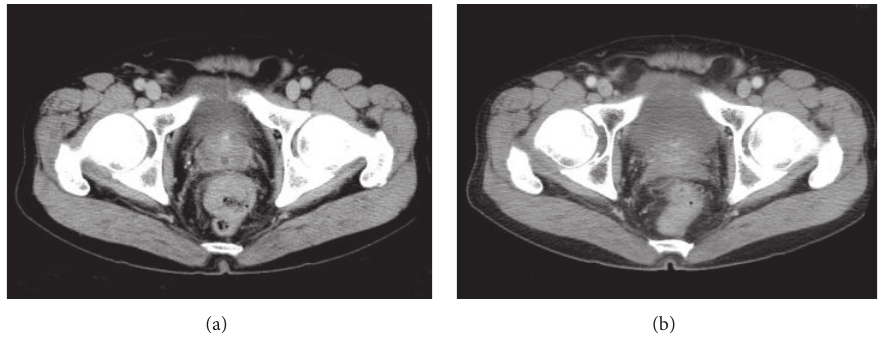
Figure 2: Abdominal computed tomography (CT) findings both (a) before and (b) after